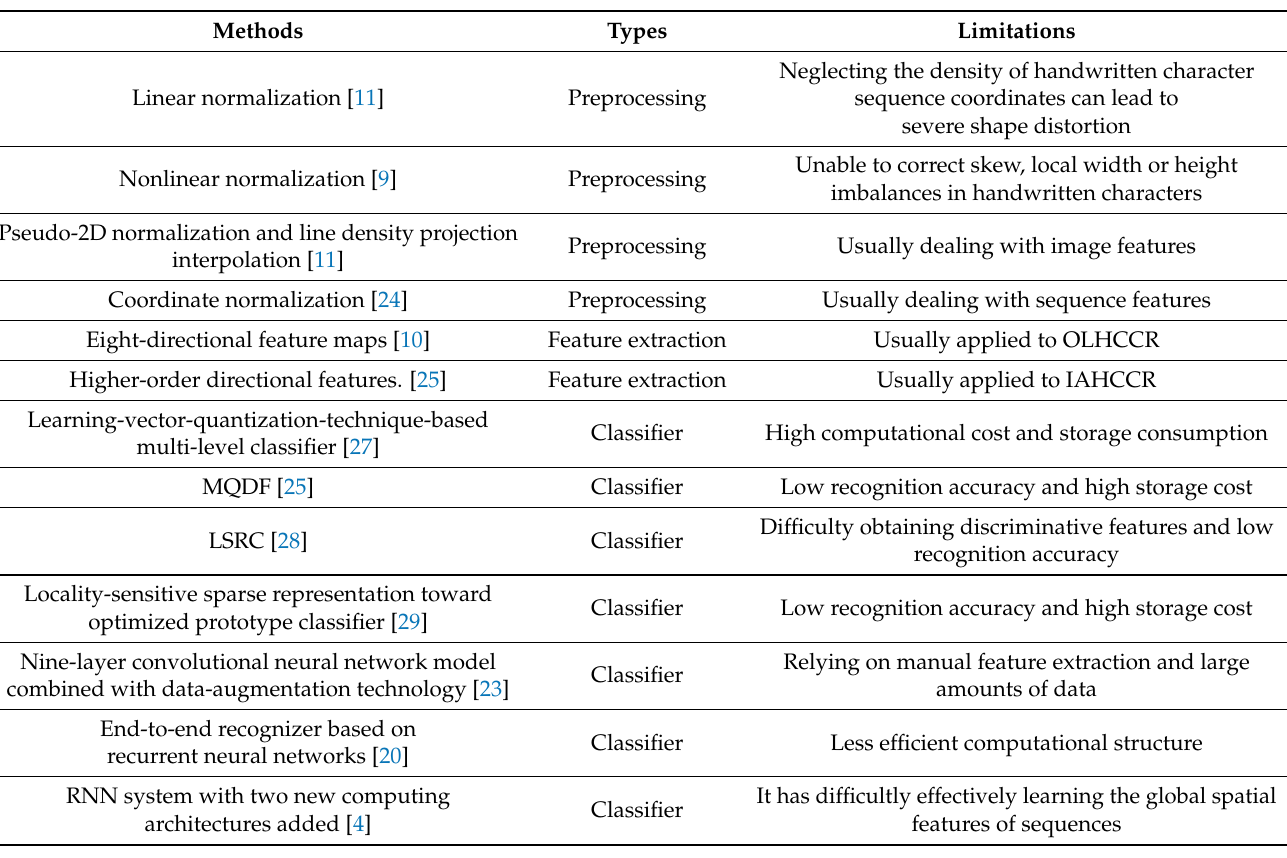
Table 1. Summary of related